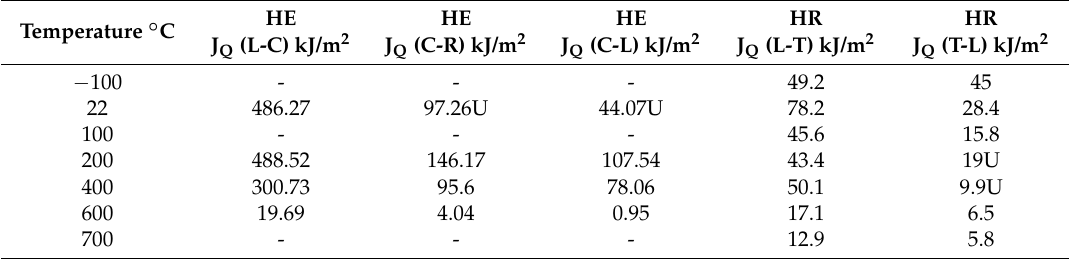
Figure 6. Comparison of L-T oriented specimen of ODS-KIT HR with L-C oriented specimen of ODS-KIT HE using ( a ) Fracture toughness versus yield strength curve at various temperatures and ( b ) Load versus load line displacement at RT along with ( c ) Load versus load line displacement curve of ODS-KIT HR in all the orientations at RT and ( d ) Load versus load line displacement curve of ODS-KIT HE in all the orientations at RT. Table 3 . Fracture toughness (J Q ) values for ODS-KIT HE and ODS-KIT HR at various temperatures (from [17,18]).